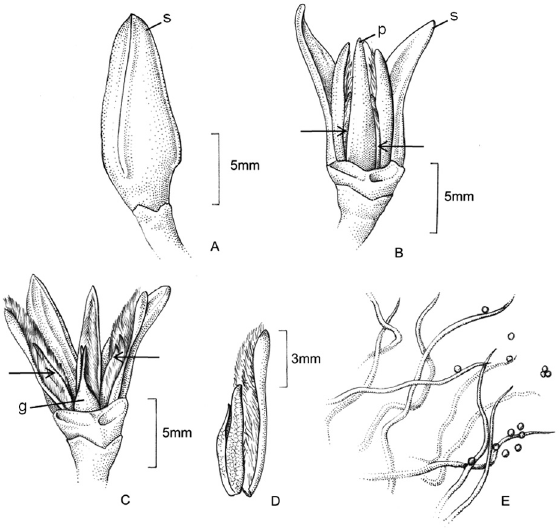
Fig. 2 - arrangement of floral whorls and deposit of pollen grains on trichomes of the petals of pre-anthesis buds of Rhizophora mangle L. (Rhizophoraceae), in goiana, Pernambuco, Brazil. A. Pre-anthesis bud. B-C. Arrangement of petals and stamens, evidencing the whorl of stamens (arrows) alternate with the petals (B), and the whorl of stamens (arrows) opposed to the petals, involved by trichomes (C). D. Anther dehiscence. E. Diagram of pollen grains attached to the trichomes of the petals. s = sepal; p = petal; g = gynoecium.